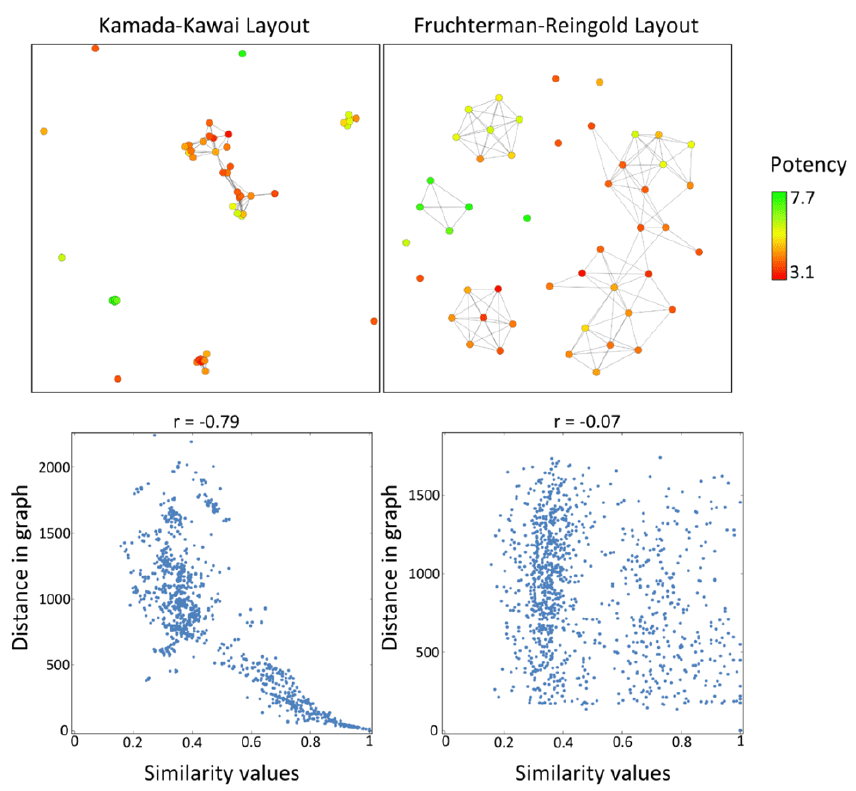
Figure 3. Comparison of Kamada-Kawai and Fruchterman-Reingold layouts. For data set 100476, KK and FR CSNs are compared at a similarity threshold value of 0.8 for selective edge display (KK) and network generation (FR). Nodes are colored according to Figure 2. At the bottom, similarity values and corresponding network distances of all compound pairs are compared in scatter plots and correlation coefficients are